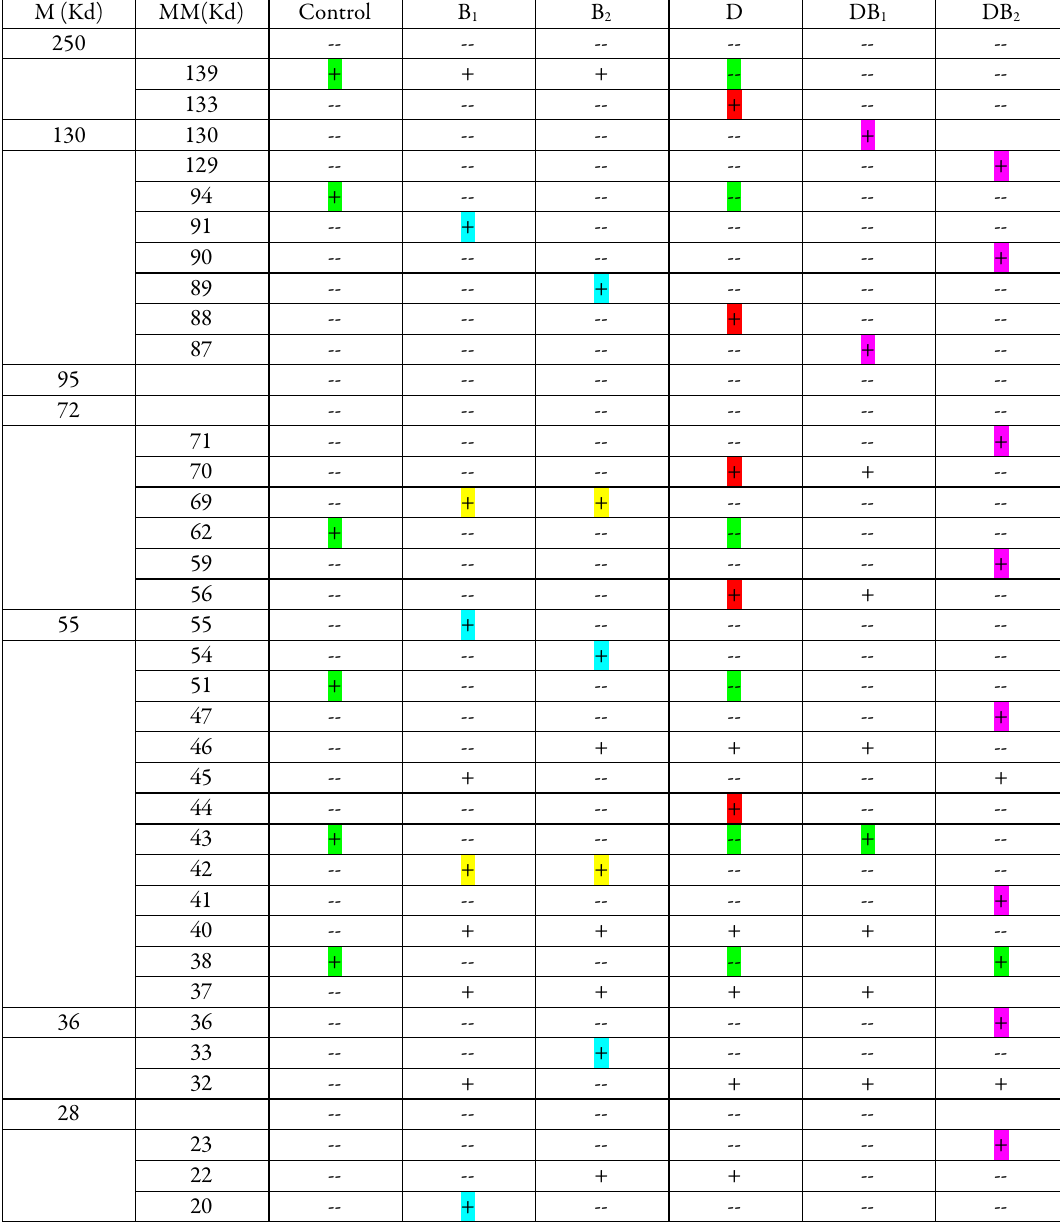
Table 3. Changes revealed by SDS-PAGE in protein patterns of the yielded-grains of Triticum aestivum (cv. ‘G9’) plants grown in sandy soil, under unstressed (irrigated every 5 days) and drought stressed (irrigated every 10 days) conditions without and with inoculation with A. brasilense NO40 ( B 1 ) and S. maltophilia (B 2 ) M